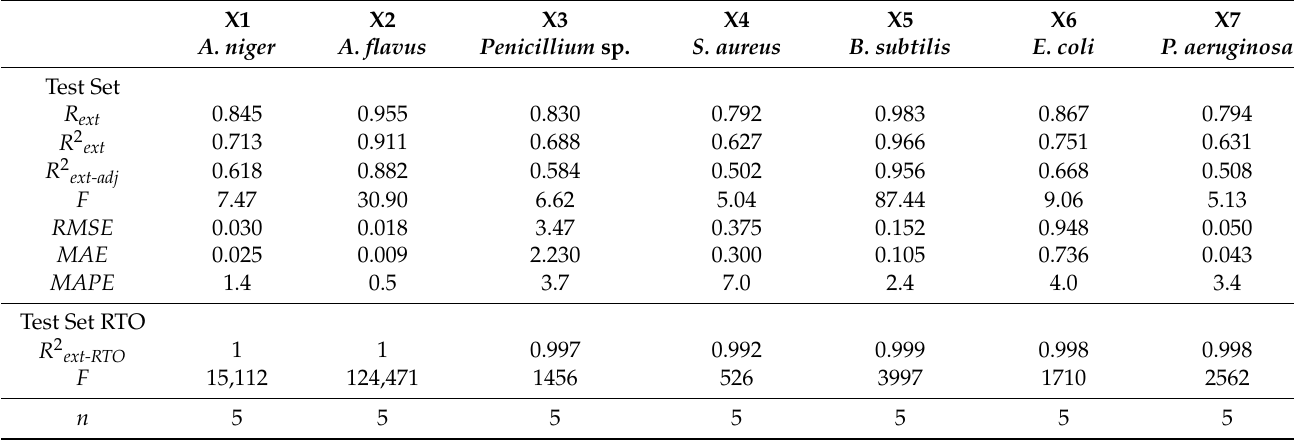
Table 5. Test set parameters of quantitative structure–activity relationship models of triazolothiadiazine compounds for antifungal and antibiotic activities.